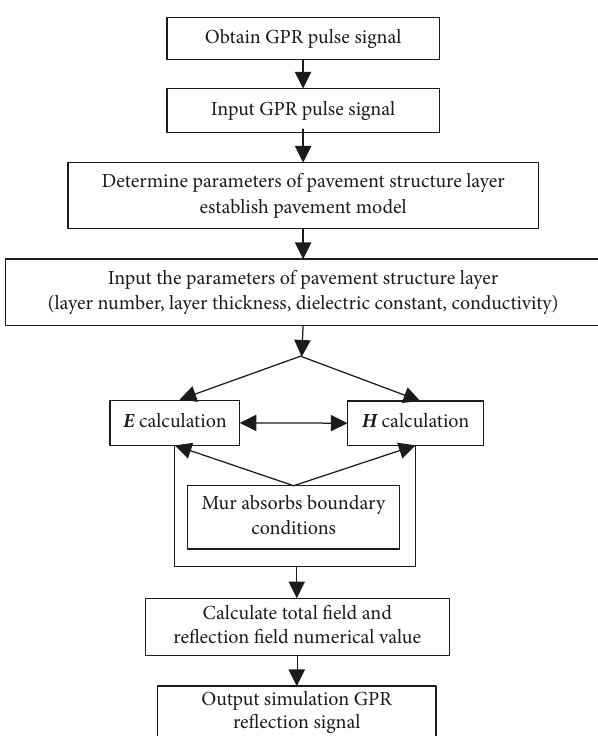
Figure 7: The forward modeling procedure of GPR electromagnetic wave in the pavement structures.